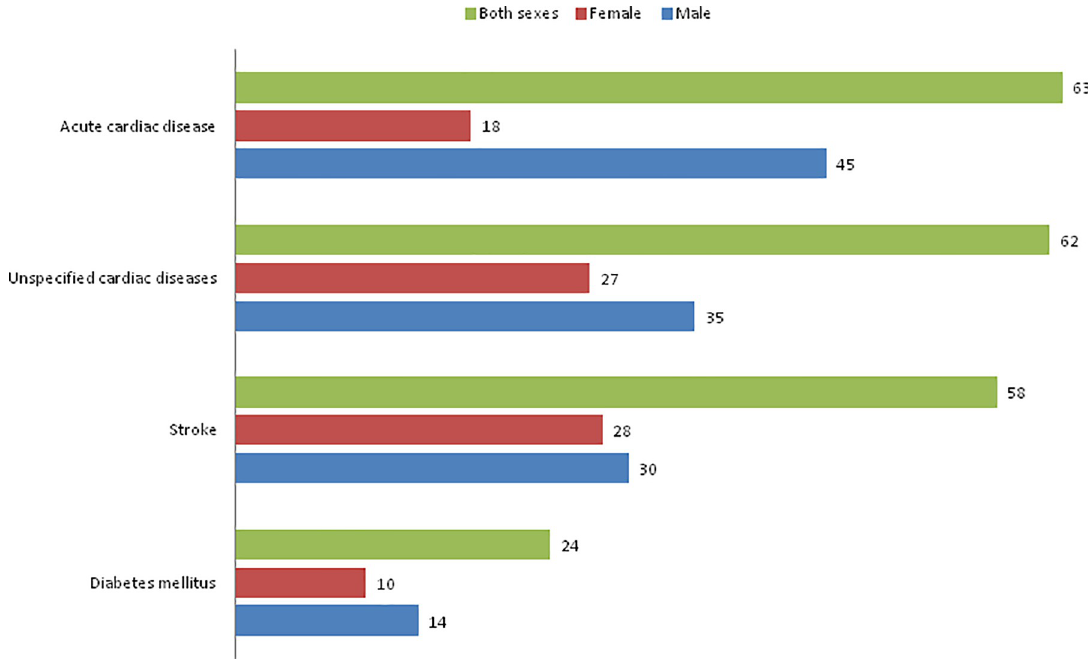
Fig 2. Numbers of deaths from emerging non-communicable diseases, PNGIMR’s CHESS, 2020.